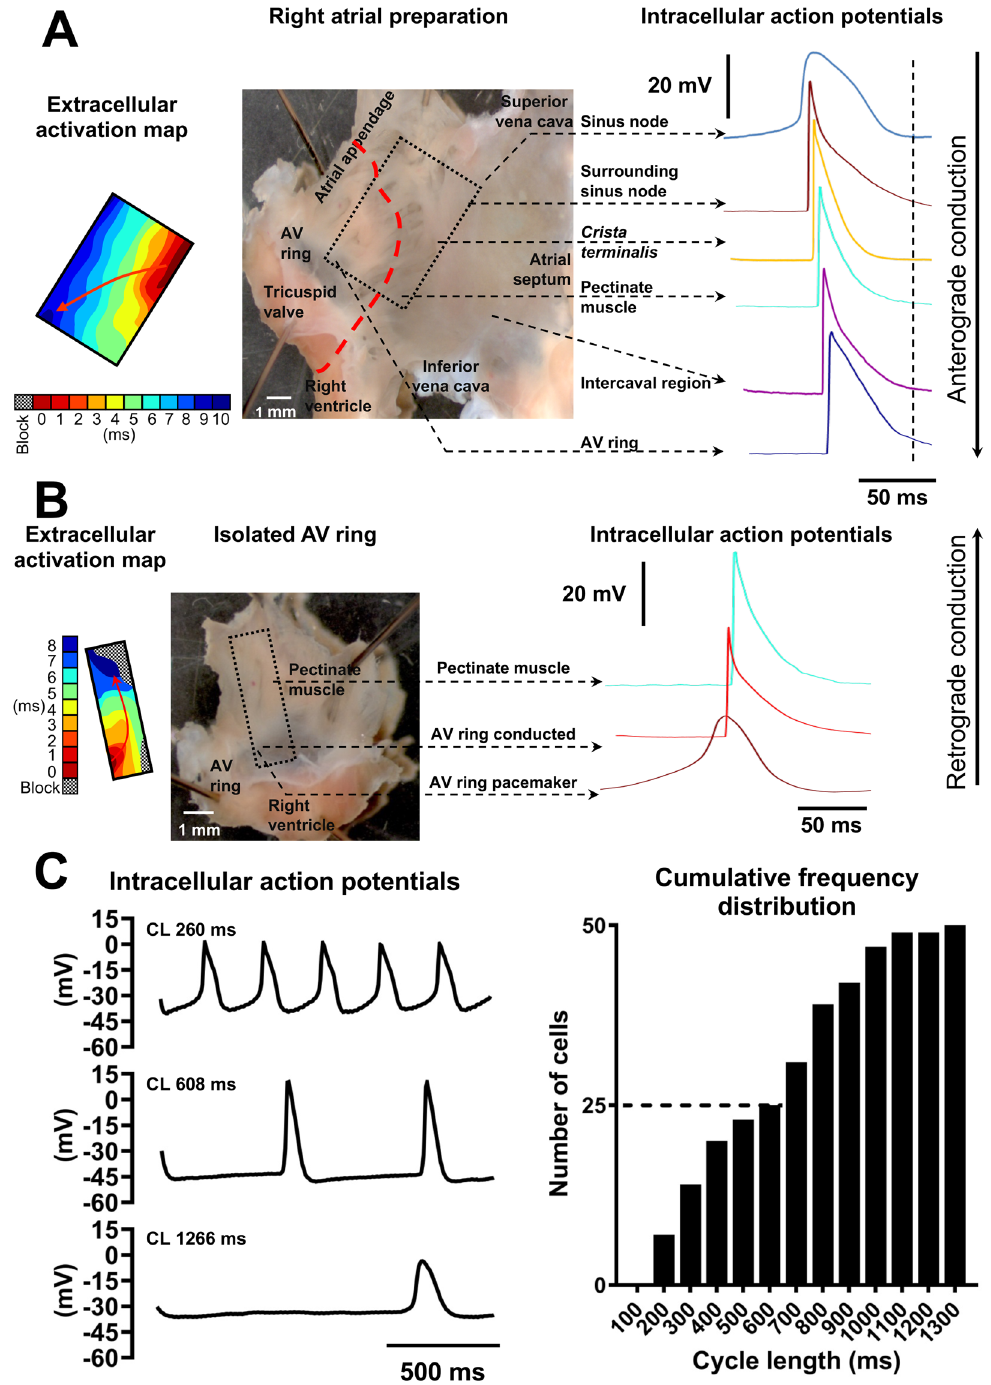
Figure 1. Action potential heterogeneity in the rat right atrium. ( A ) Middle, right atrial preparation with intact sinus node and atrioventricular ring (AV ring). Box denotes mapping array (8 × 8 electrodes) position. Left, extracellular electrical activation map is shown. Red arrow denotes direction of action potential propagation. Right, typical intracellular action potentials are shown arbitrarily shifted to the right and downward for clarity of presentation. ( B ) AV ring isolated by cutting along red dashed line drawn on tissue preparation shown in A. Box denotes mapping array (6 × 10 electrodes) position. Extracellular electrical activation map shown to the left of tissue. Action potentials at AV ring leading pacemaker site, AV ring conducted and pectinate muscles shown to the right. ( C ) AV ring pacemaker action potentials with fast (top), average (middle) and slow (bottom) cycle lengths (CL). Right panel shows cumulative frequency distribution histogram of CLs in AV ring pacemaker cells (n = 50 cells in 21 AV rings). Vertical and horizontal scale bars represent voltage (mV) and time (ms),